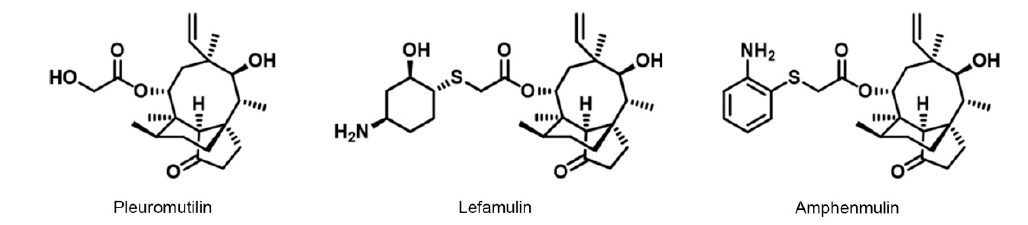
Figure 1. Structure of pleuromutilin, lefamulin, and amphenmulin.